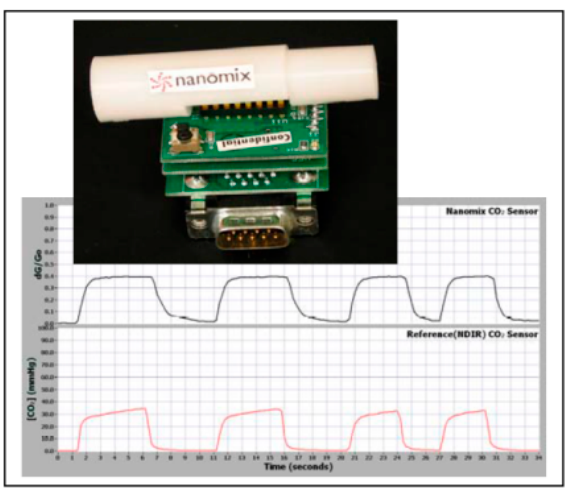
Figure 10. Field effect transistor using carbon nanotubes (NTFET) sensor fabricated for carbon dioxide. Reproduced with permission from Reference [28].